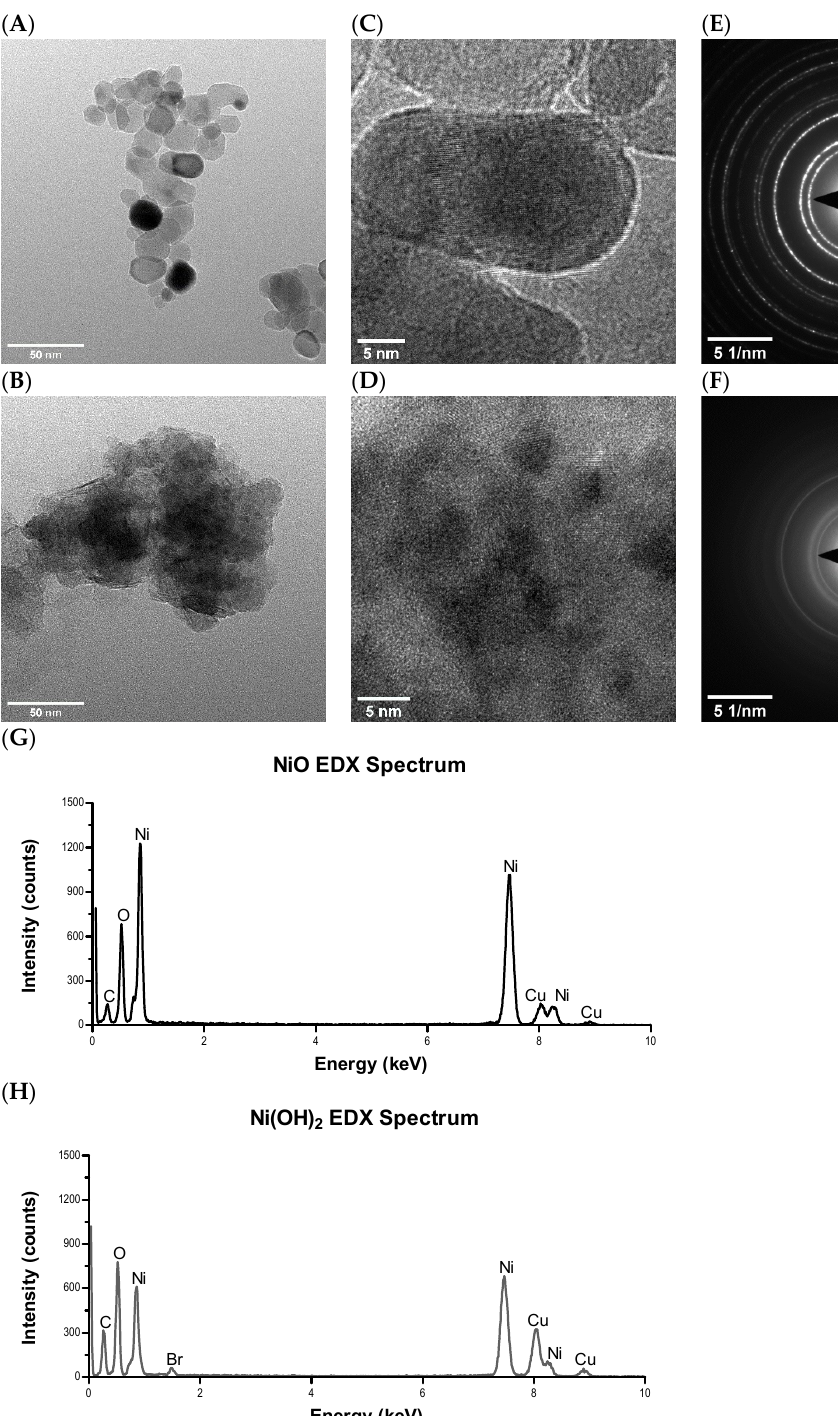
Figure 1. Morphology of ( A ) NiO and ( B ) Ni(OH) 2 nanoparticles (NPs) from TEM bright field images. The lattice fringes of ( C ) NiO and ( D ) Ni(OH) 2 polycrystals are visible from high resolution transition electron microscopy (HRTEM) images. Selected area electron diffraction (SAED) patterns of ( E ) NiO and ( F ) Ni(OH) 2 are shown with (hkl) and 1/distance (1/nm) values for prominent rings indicated. The energy disperse X-ray spectroscopy (EDX) spectra of ( G ) NiO and ( H ) Ni(OH) 2 show that both particles are composed of Ni and O, with C and Cu peaks being attributed to the TEM grid material.